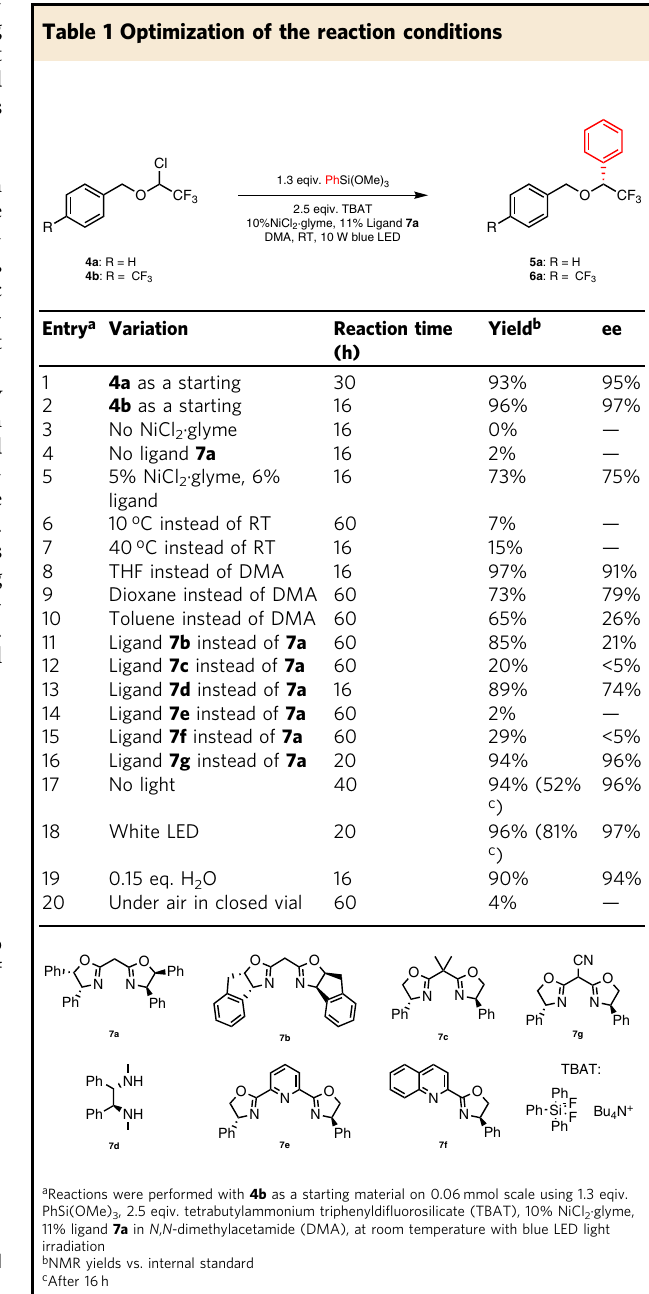
Fig. 2 Approaches towards chiral α -tri fl uoromethyl alcohols. Asymmetric hydrogenation represents a major way to prepare enantiospeci fi c α -CF 3 benzyl alcohols. Our approach is based on asymmetric cross-coupling reaction of